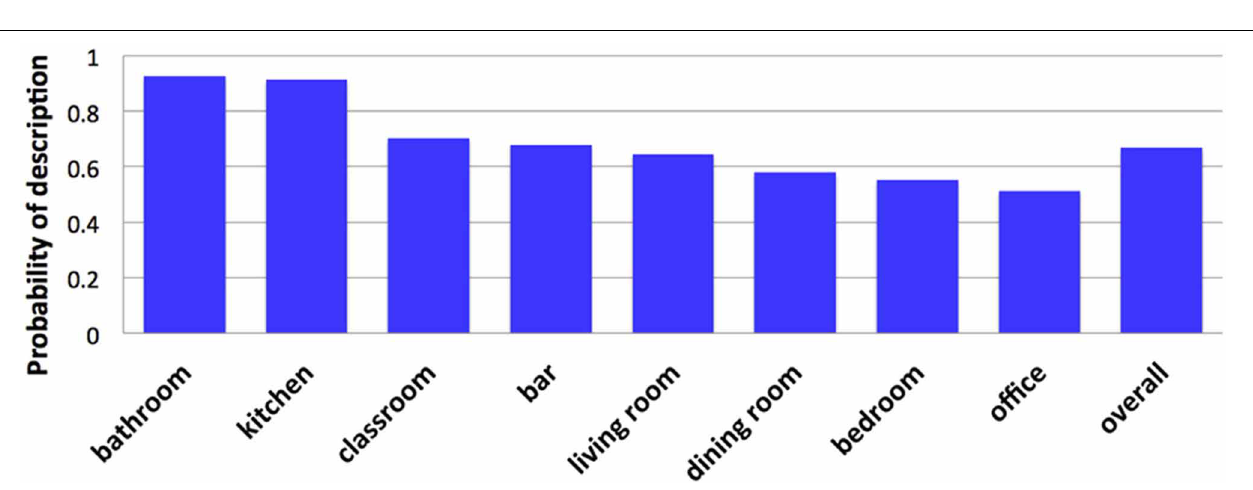
FIGURE 10 | Probability that a scene name was included in a description as a function of category.